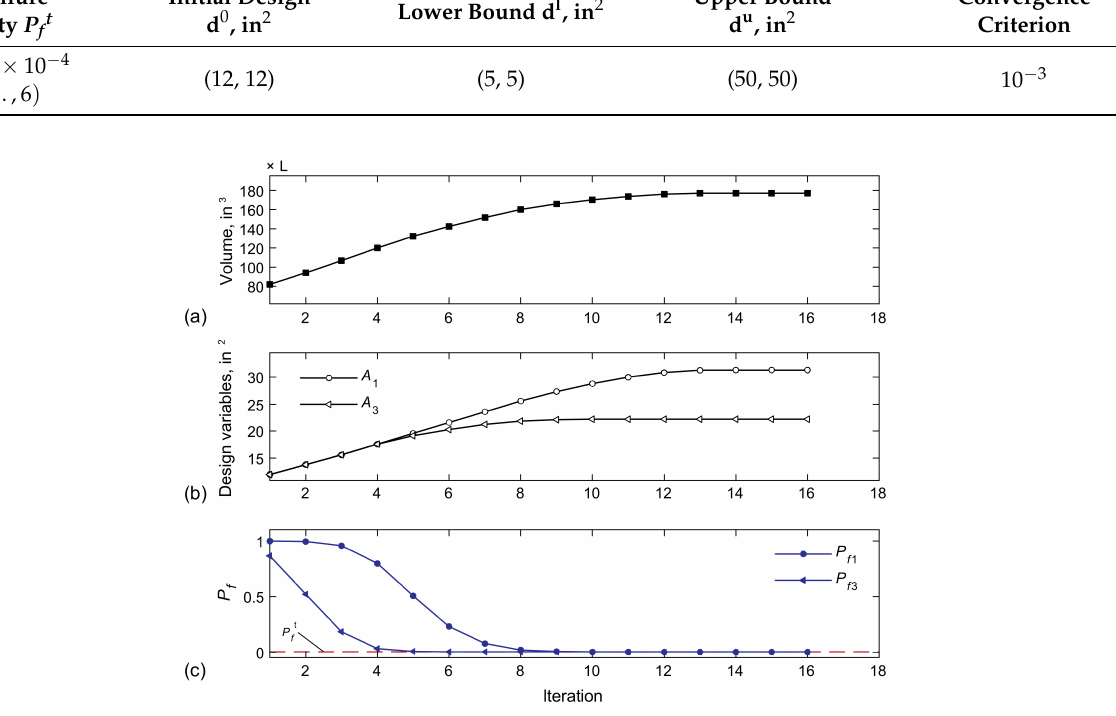
Figure 8. Convergence histories of the proposed RBDO − CS method: ( a ) optimal volume; ( b ) design variables; and ( c ) failure